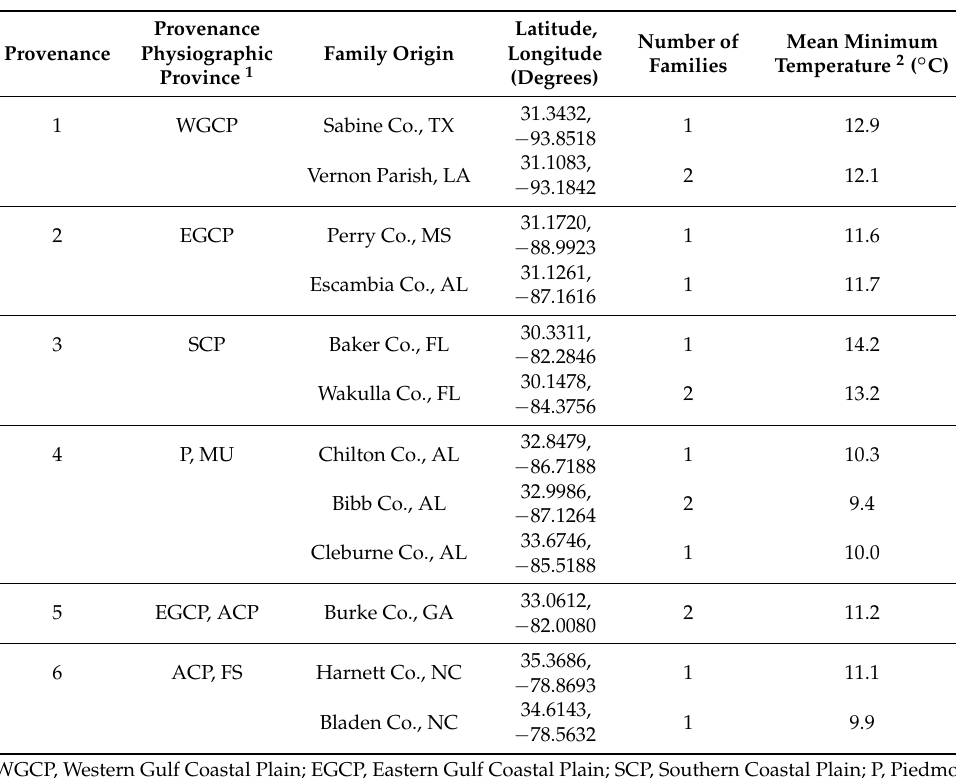
Table 1. Provenance physiographic province, origin and number of longleaf pine families studied per provenance, and mean minimum temperature at the family origin.